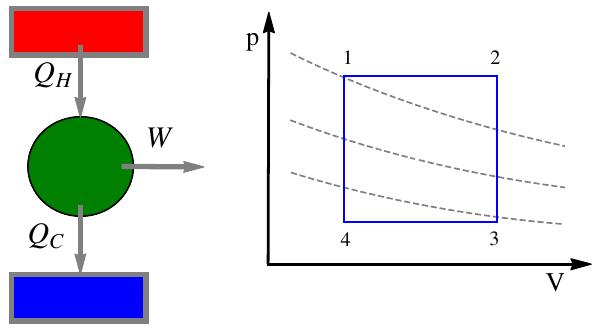
Fig. 1 Heat engine and a rectangular cycle with